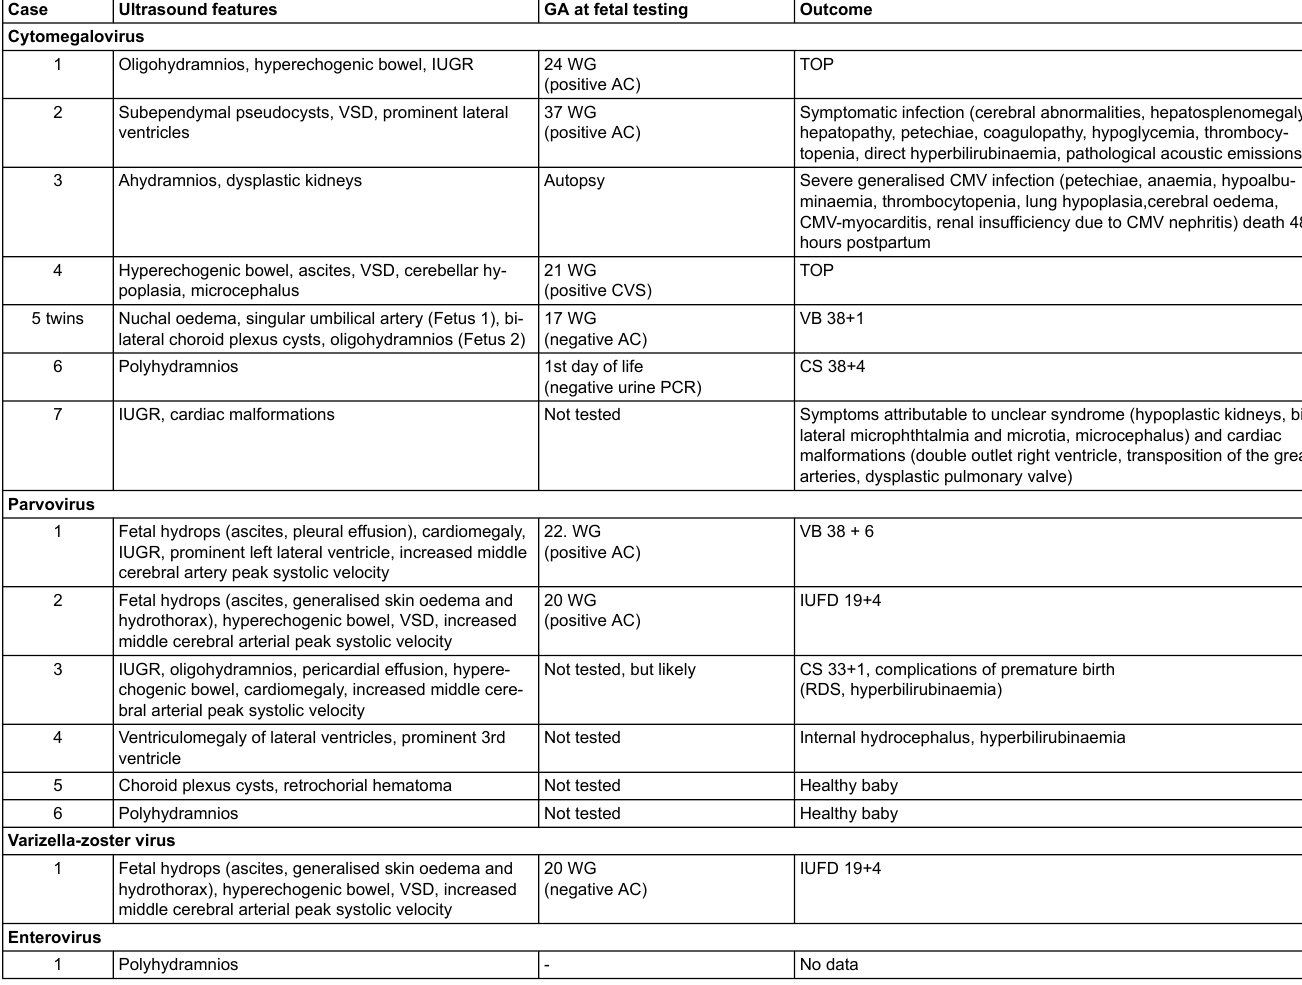
Table 2: Pregnancy outcomes in cases of confirmed maternal infections.